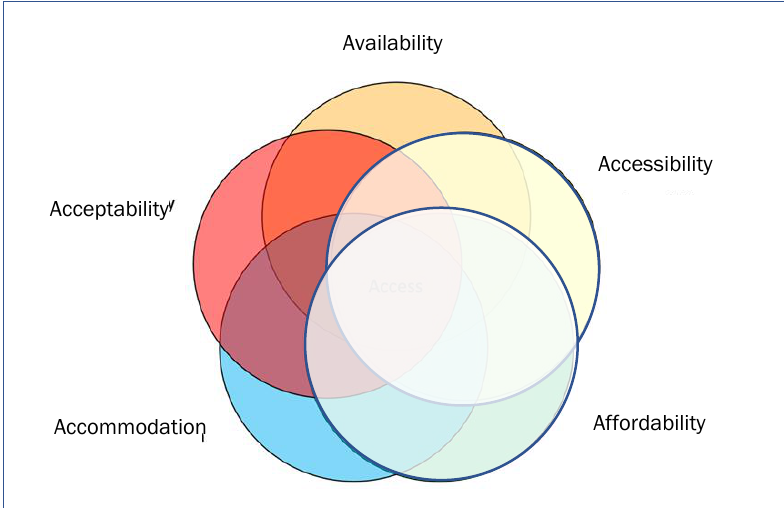
Figure 3. Limits to Access Due to Liability and